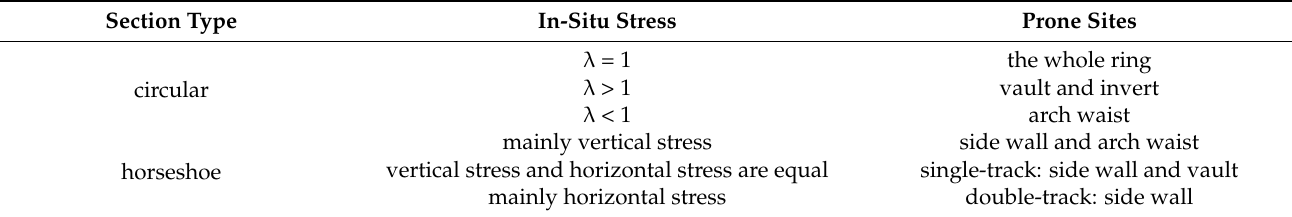
Table 8. Summary of rockburst prone sites under different conditions.